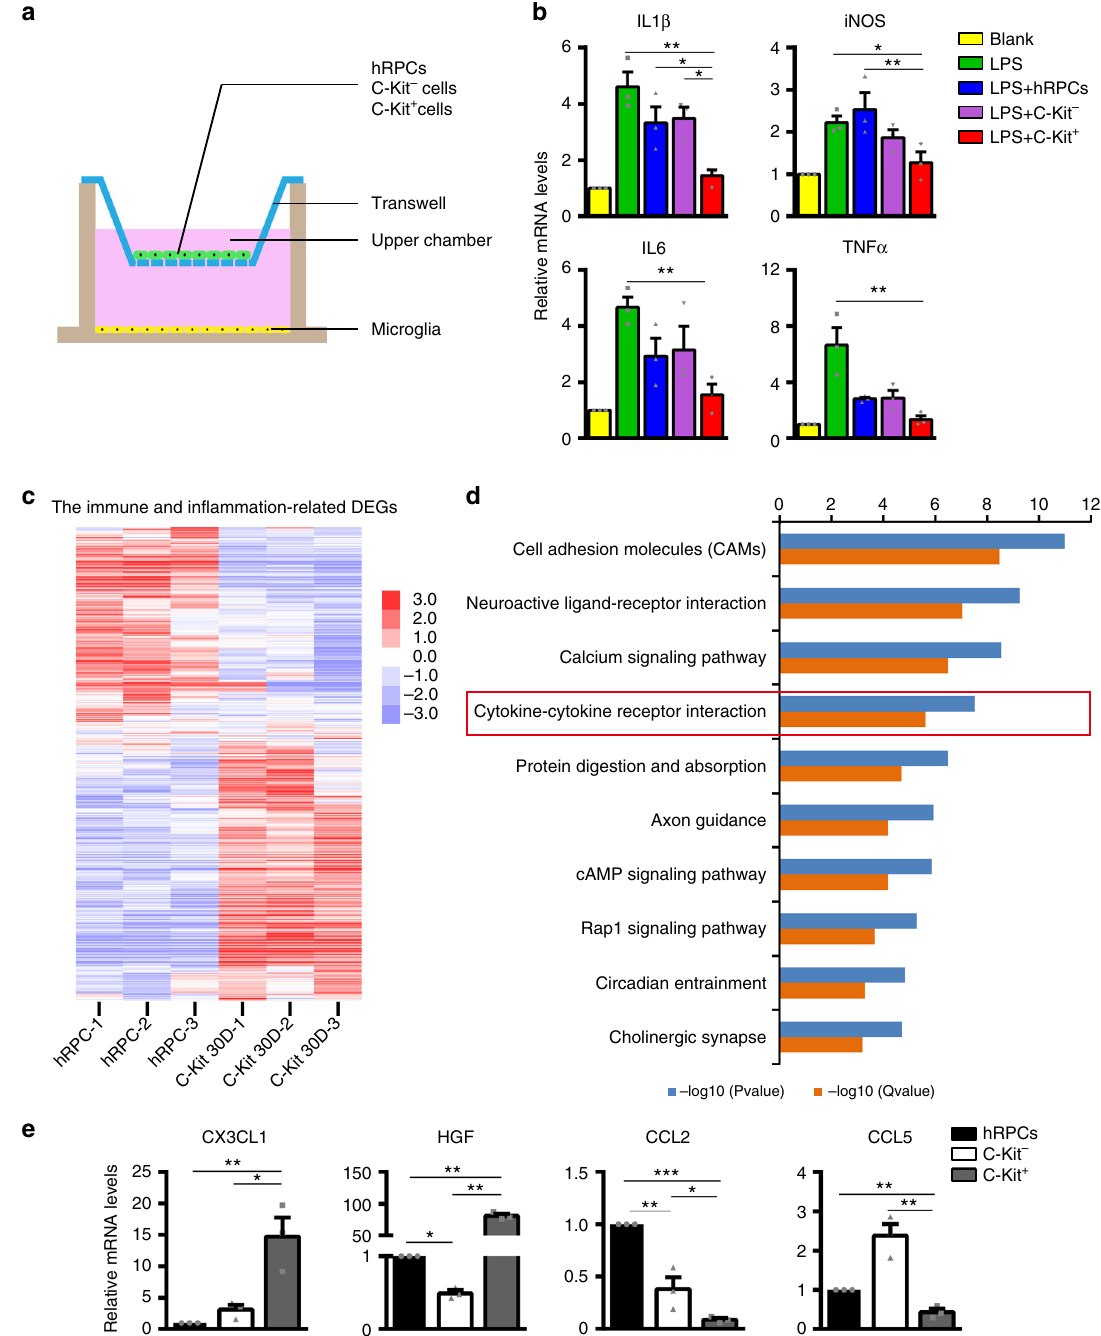
Fig. 9 Immune-related transcriptome analysis of C-Kit + cells and primary hRPCs. a Diagram of co-culture system. b Relative mRNA levels for the in fl ammatory factors IL1 β , iNOS, IL6, and TNF α in LPS-stimulated human microglia cells co-cultured with C-Kit + cells, C-Kit − cells and hRPCs (1 × 10 4 cells). Human microglia cells were stimulated with 1 μ g/ml LPS for 12 h. n = 3 independent experiments/group. c Heatmap analysis showing differentially expressed immune and in fl ammation-related genes in C-Kit + cells from 30-day hEROs and hRPCs based on Gene Ontology Analysis (listed in Supplementary Data 2). Log2 expression levels of the genes are shown as a red-white-purple gradient. d KEGG pathway analysis of differentially expressed genes showing the top ten pathways associated with genes that are differentially expressed in C-Kit + cells from 30-day hEROs and hRPCs (listed in Supplementary Data 3) ( n = 3 biologically independent samples/group). e Real-time qPCR analysis showing relative mRNA expression for the microglia- suppressing cytokines CX3CL1 and HGF and the microglia/macrophage recruitment-related cytokines CCL2 and CCL5 in C-Kit + cells, C-Kit − cells and hRPCs ( n = 3 independent experiments/group). P values were determined by one-way ANOVA followed by Tukey multiple comparison tests ( b , e ) * P < 0.05; ** P < 0.01; *** P < 0.001. Data are presented as mean ± SEM. IL1 β interleukin-1-beta, iNOS inducible nitric oxide synthase, IL6 interleukin-6, TNF